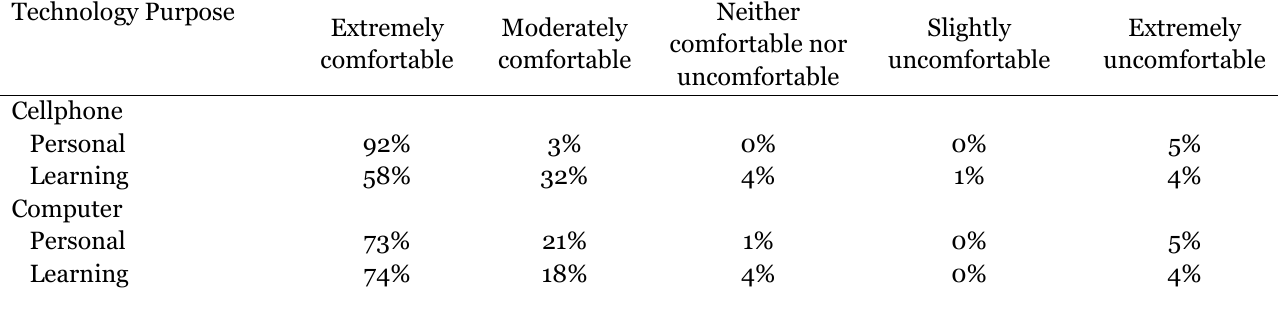
Comfort Level Using Technology for Personal Versus Learning